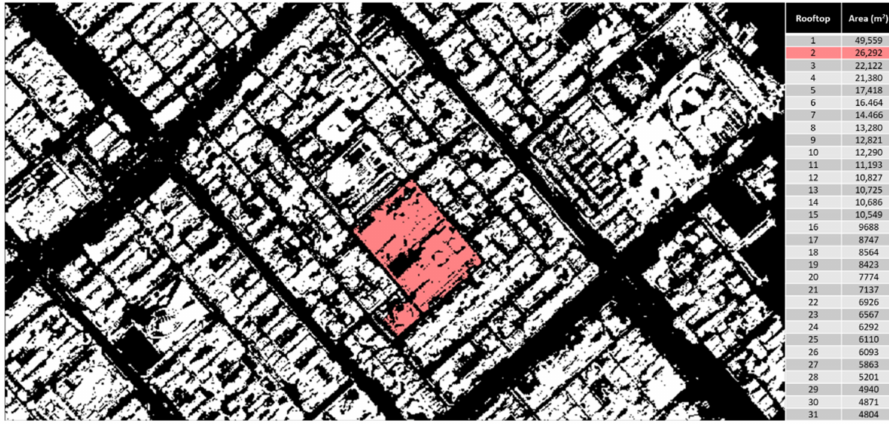
Figure 4. Rooftop area calculation for the sample region within Abu Dhabi city in m 2